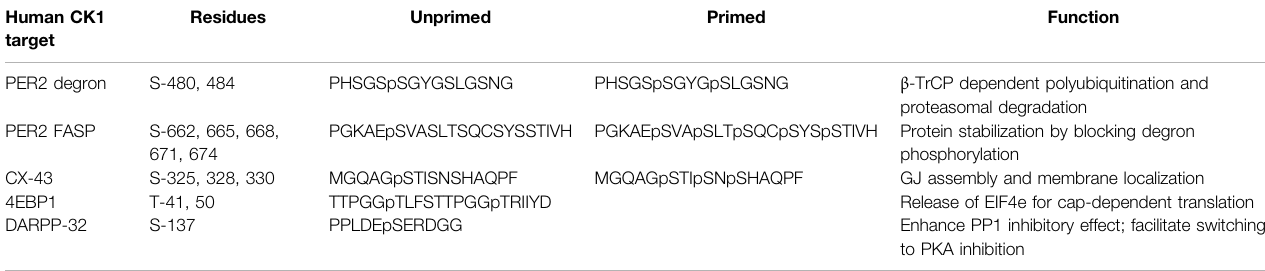
TABLE 1 | CK1 target sites in PER2, Connexin-43, 4EBP1 and DARPP32. Human CK1